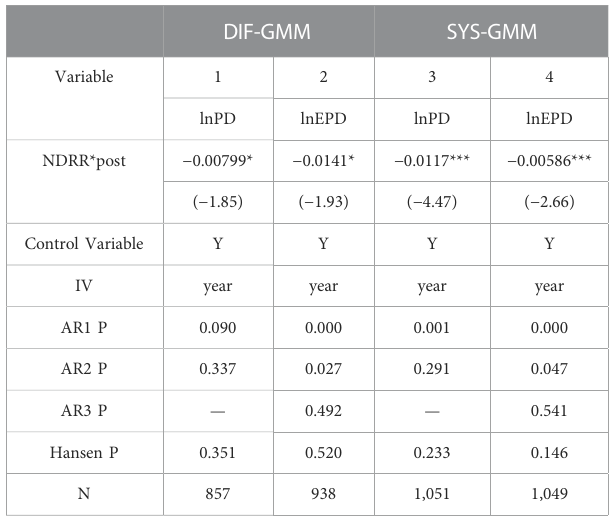
TABLE 8 Endogenous